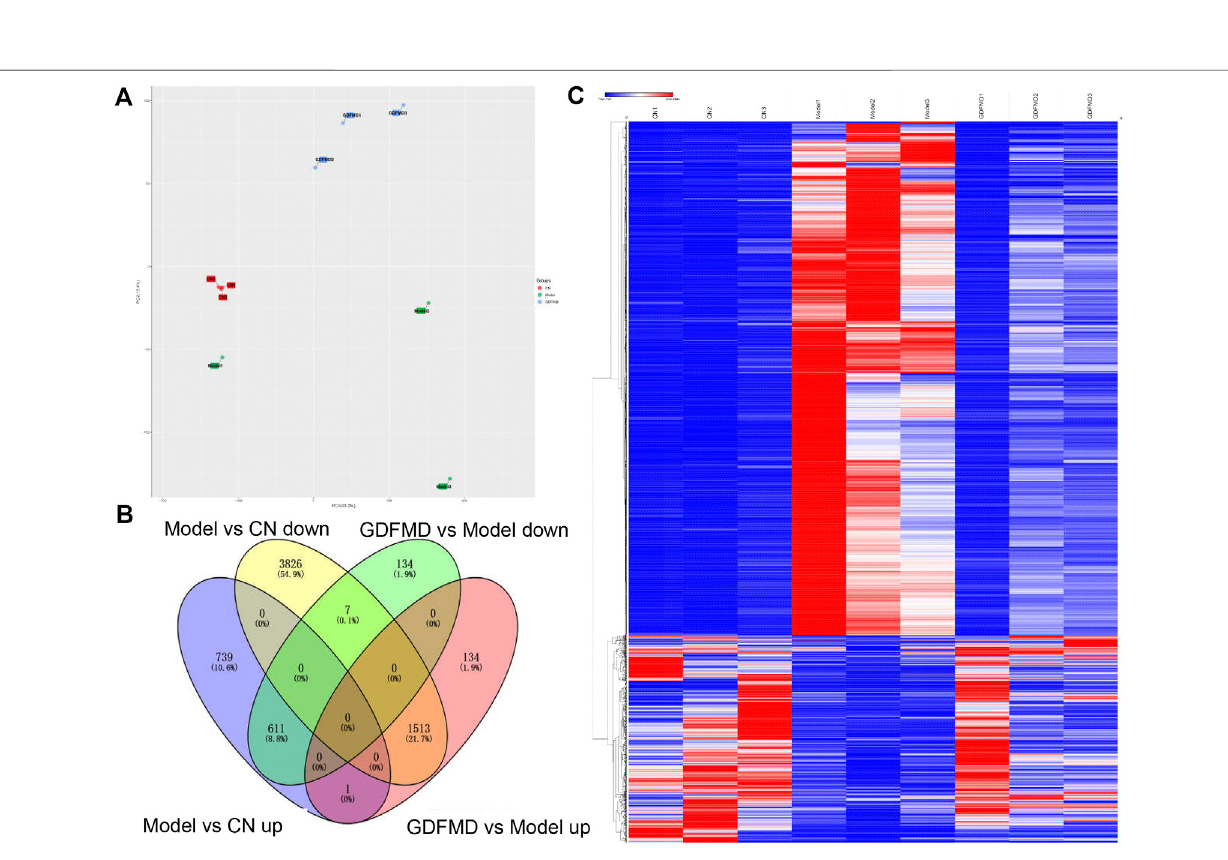
Frontiers in Pharmacology |